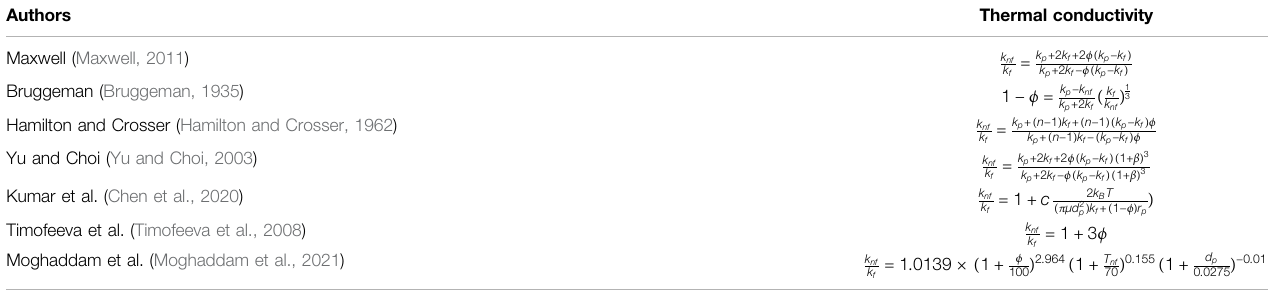
TABLE 2 | Calculation models of thermal conductivities of nano fl uids.